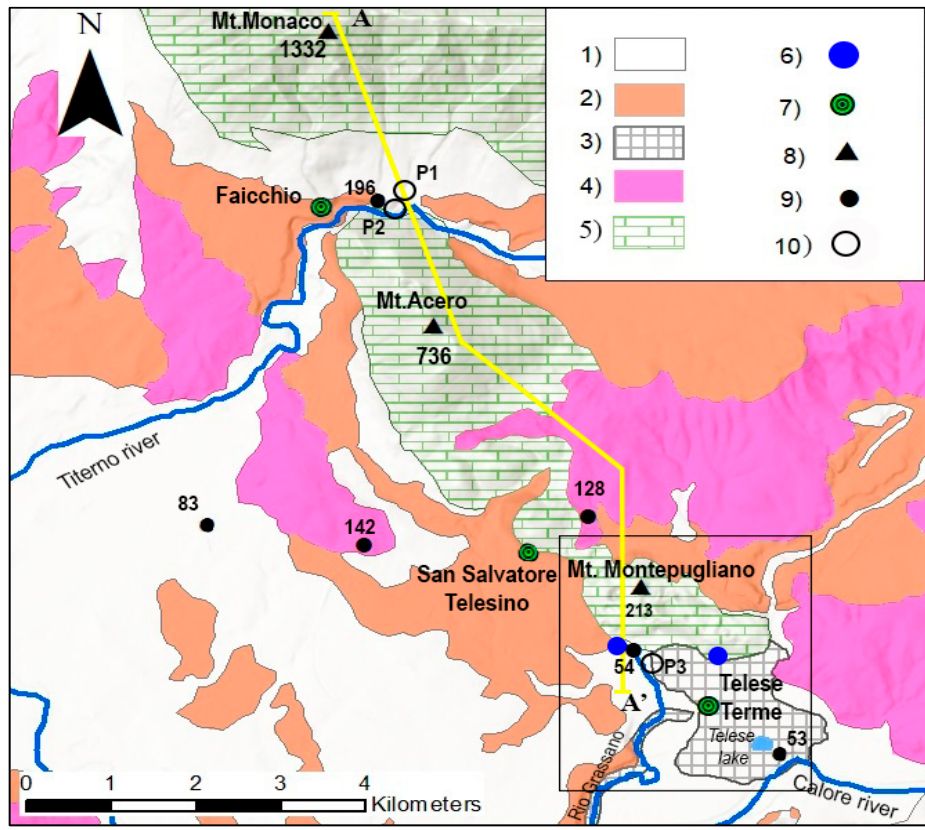
Figure 4. Overview of the Telese karst area: (1) Alluvial and lacustrine deposits of the Telese plain (Quaternary); (2) Campanian Ignimbrite and pyroclastic deposits (Quaternary); (3) travertine deposits (Quaternary); (4) argillaceous complex and flysch sequences (Paleogene–Miocene); (5) calcareous dolomite series (Jurassic–Miocene); (6) spring; (7) village; (8) mountain peak; (9) elevation (m a.s.l.); (10) borehole; yellow line is section trace AA ′ shown in Figure 9. The area marked with black rectangle is detailed in Figure 5.